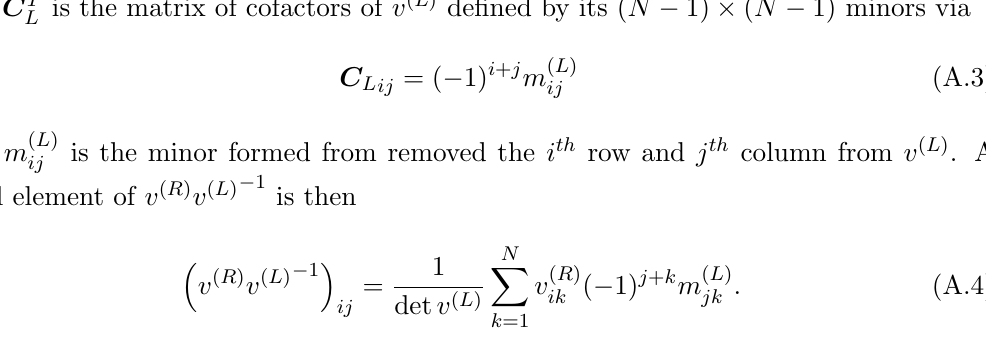
Figure 7 . (Left) The graph of v ( L ) = m , v ( R ) = the graph. (Right) The same graph as wrapped on the